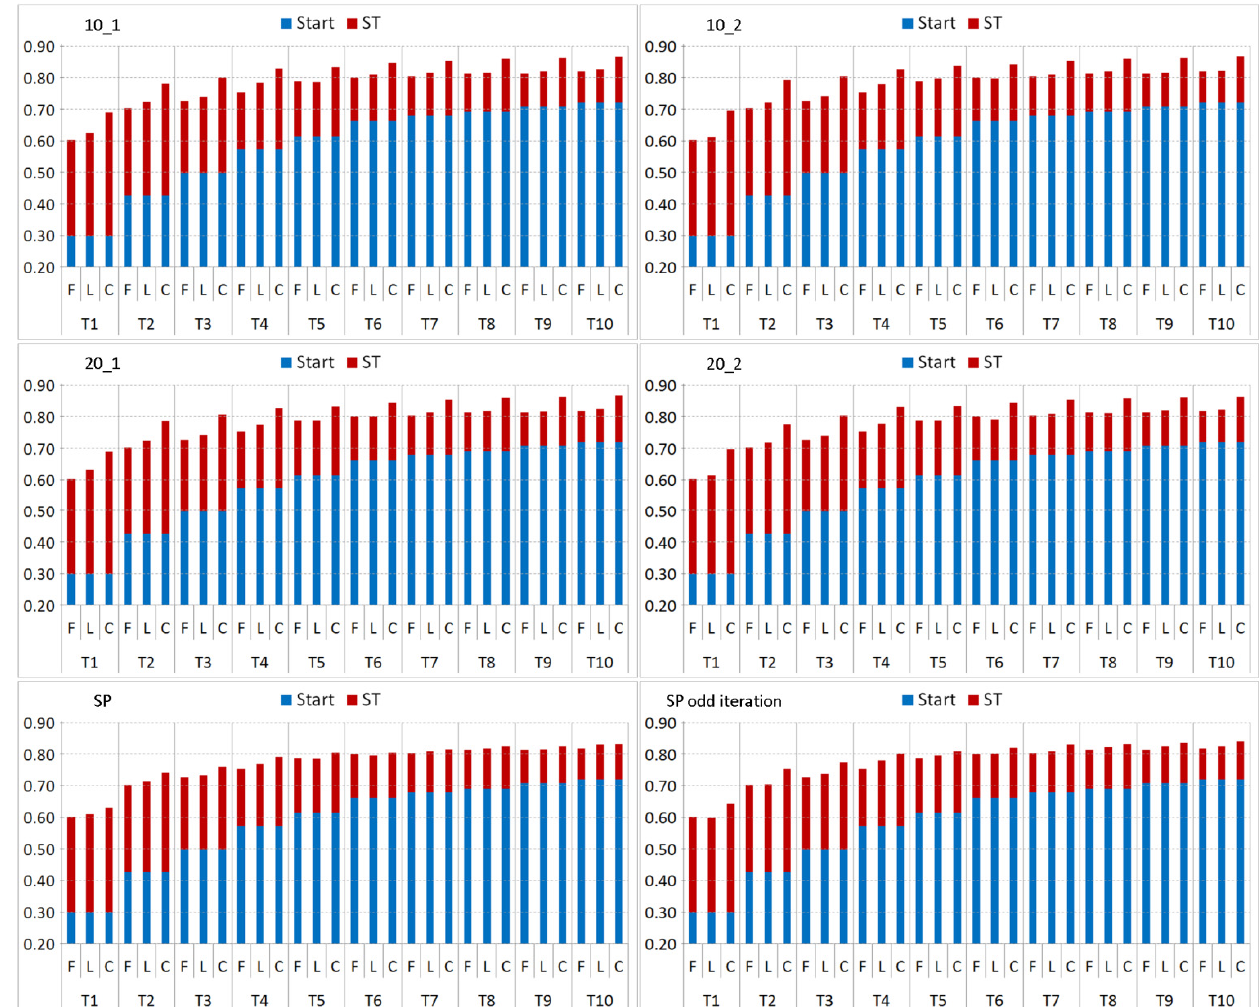
Figure 8. Classification accuracies for different training sets T methods for the unlabeled samples over the four circular combinations and two superpixel methods using RF as base learner. The selection methods are abbreviated as F ( full ), L (NH ), and C (NH L C